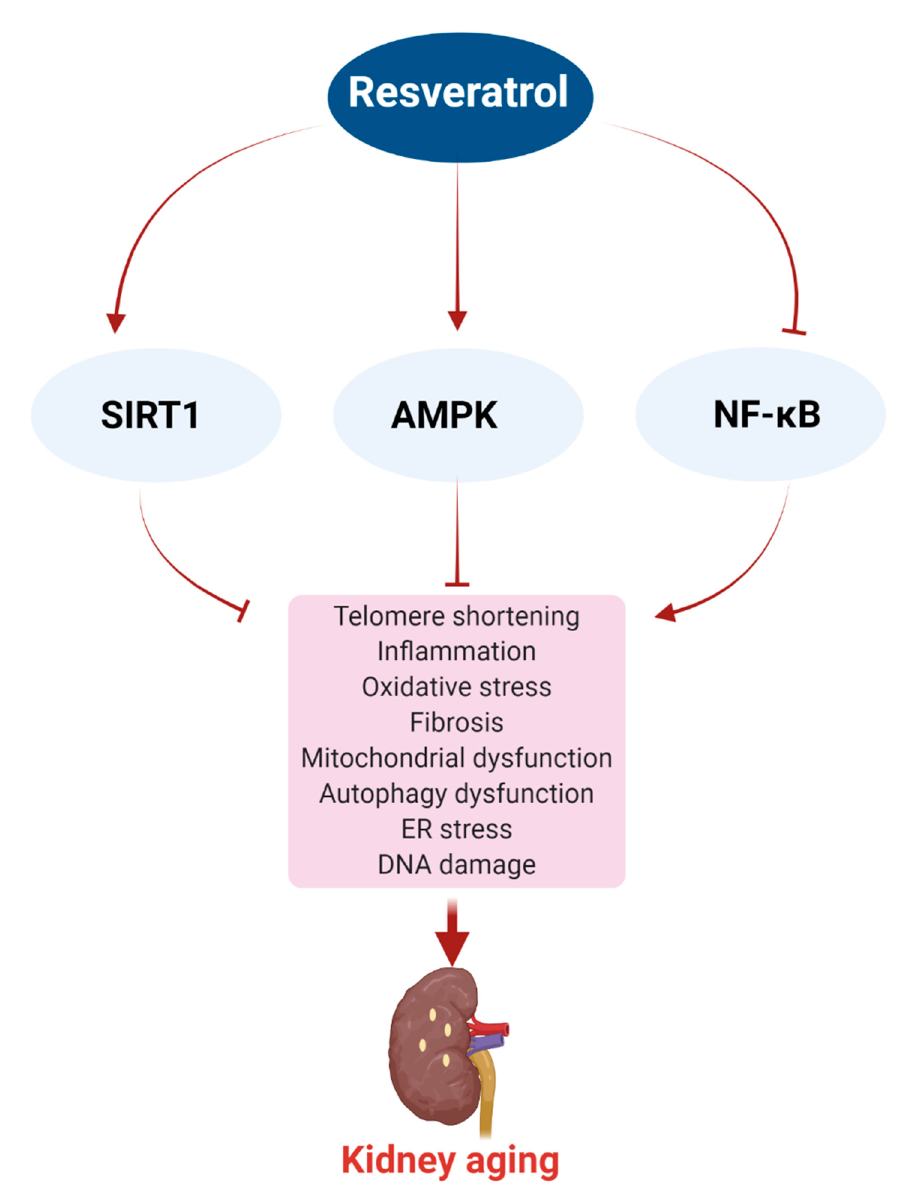
Figure 5. Potential anti-aging effects of resveratrol in the kidney. Resveratrol may mediate anti-aging effects in the kidney through the regulation of three main signaling pathways, SIRT1, AMPK, and NF- κ B, which ultimately suppress pathological conditions, such as telomere shortening, inflammation, oxidative stress, fibrosis, mitochondrial dysfunction, autophagy dysfunction, ER stress, and DNA damage, in the kidney. Arrow means activation, and ‘T’ arrow means inhibition.